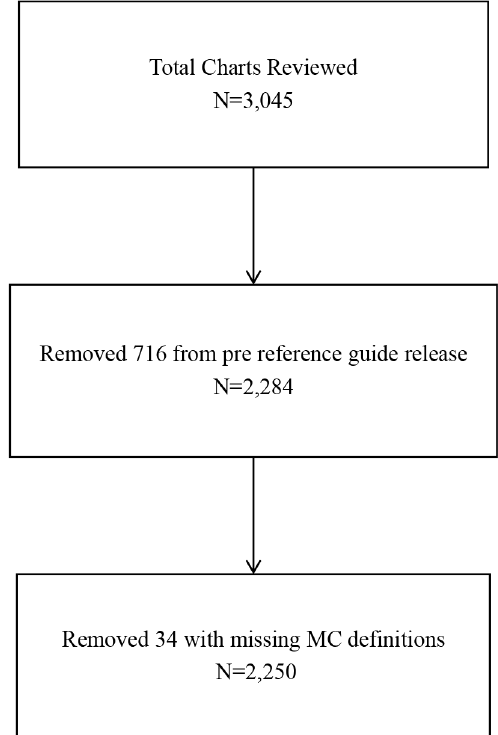
Figure 1: Flow diagram of final cohort used for chart